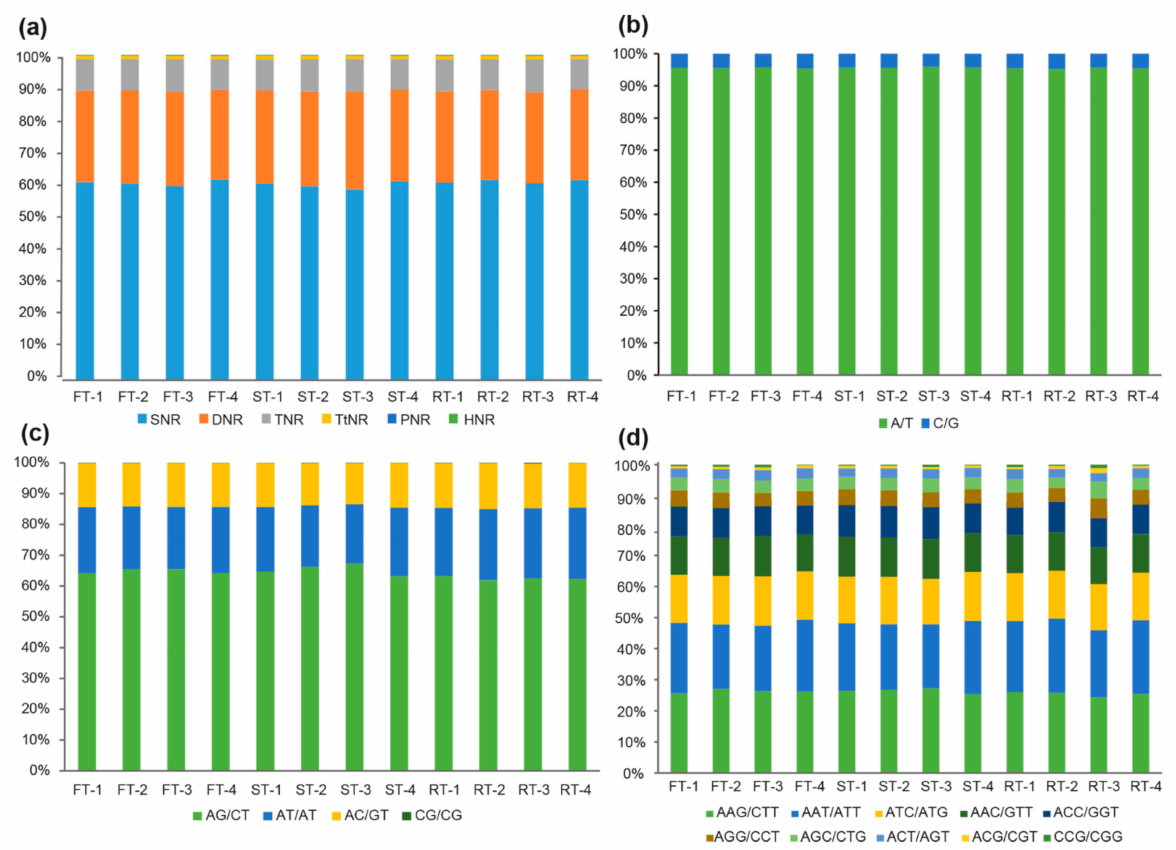
Figure 1. Frequency and distribution of SSR motifs in three fruit tissues of A. trifoliata (FT: flesh, ST: seed, RT: rind, -1: young stage, -2: enlargement stage, -3: coloring stage, -4: mature stage). ( a ) The proportion of different repeat unit lengths, ( b ) the proportion of different repeat motifs within SNRs, ( c ) the proportion of different repeat motifs within DNRs, and ( d ) the proportion of different repeat motifs within